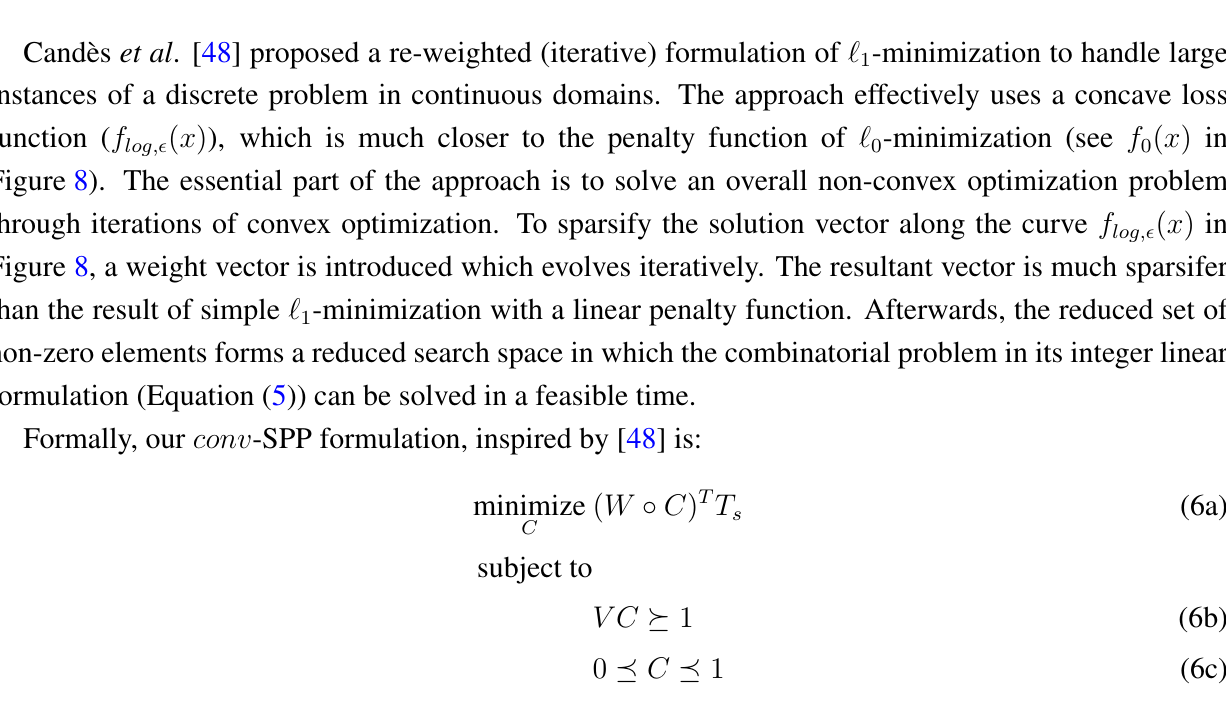
Figure 8. The concave loss function f than by the traditional convex (cid:96)